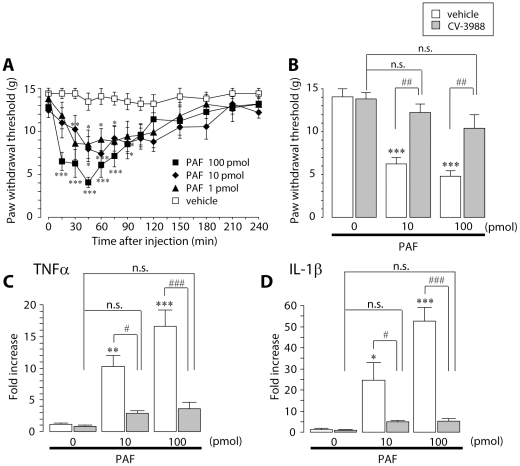
Injection of PAF near the DRG induces a decrease in the paw withdrawal threshold and upregulation of TNFα and IL-1β mRNAs.A. Paw withdrawal threshold was decreased by single administration of several different doses of PAF near the DRG in normal rats. *p<0.05, **p<0.01, ***p<0.001 compared with the threshold of the vehicle-treated group. B. The PAF-induced decrease in paw withdrawal threshold was suppressed by pretreatment with CV-3988. ***p<0.001 compared with the threshold of the vehicle-treated group. ##p<0.01 compared with the threshold of the PAF-treated group. n.s. means “not significant”. C, D. Real-time PCR analysis showed that administration of PAF near the DRG increased expression of TNFα (C) and IL-1β (D) mRNAs in the DRG 45 min after the administration. The bar graphs show the average fold increase in the level of TNFα and IL-1β mRNAs in the DRG compared with the mean expression level of these mRNAs in the vehicle-treated group. Each measurement was normalized to 18S mRNA content. *p<0.05, **p<0.01, ***p<0.001 compared with the vehicle-treated group. #p<0.05, ###p<0.001 compared with the PAF-treated group. n.s. means “not significant”. All data are presented as mean ± SEM of four to six animals.